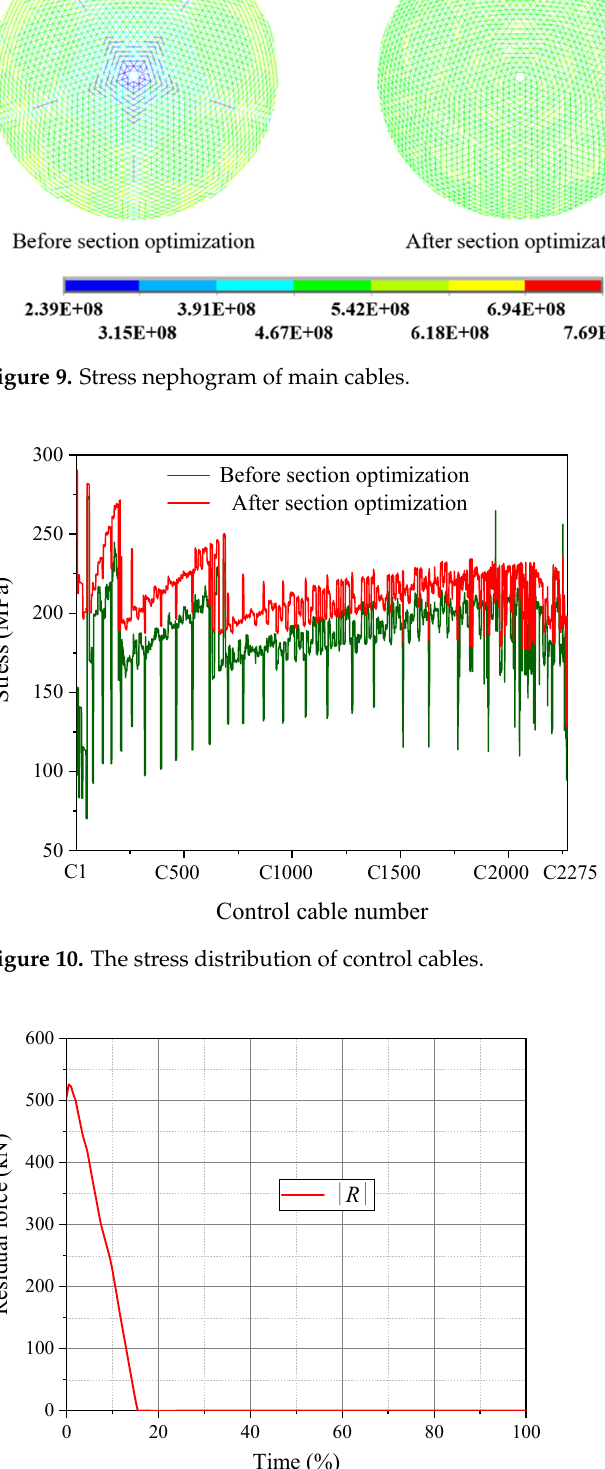
Figure 11. Change of residual force | R | over time.